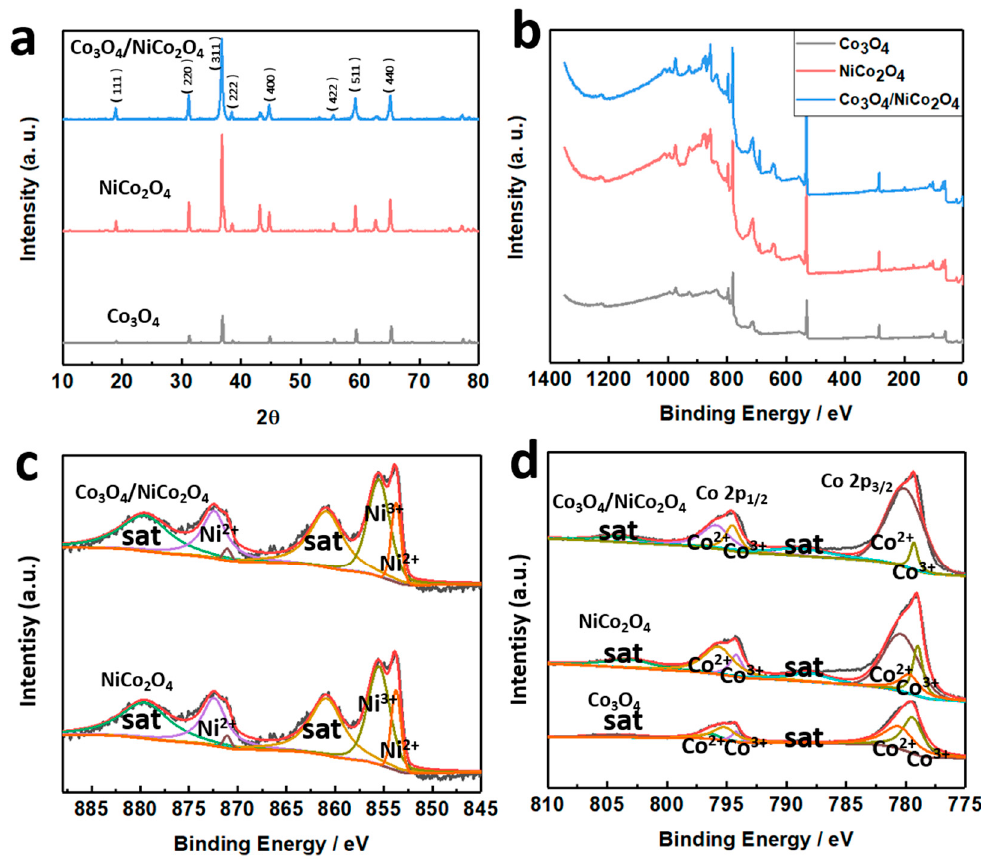
Figure 3. ( a ) XRD spectrum of Co 3 O 4 , NiCo 2 O 4 , and Co 3 O 4 /NiCo 2 O 4 , ( b ) XPS of Co 3 O 4 , NiCo 2 O 4 , and Co 3 O 4 /NiCo 2 O 4 , ( c ) the result of Ni 2p, and ( d ) Co